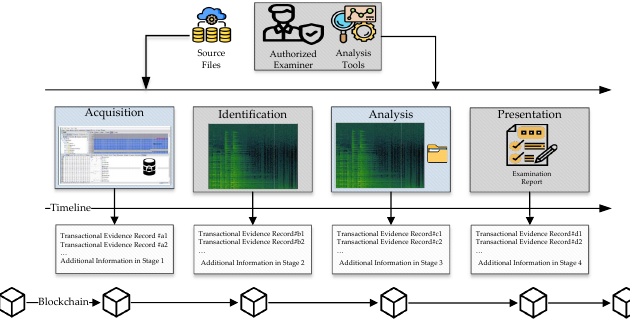
Figure 8. Details of the process of the blockchain framework for forensic